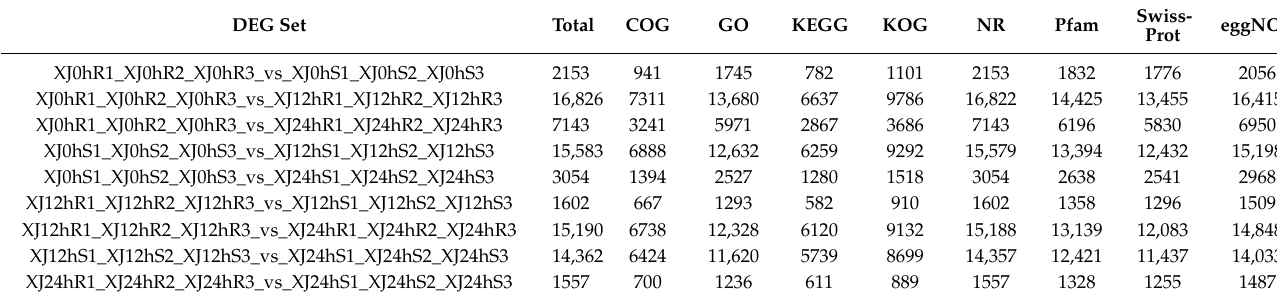
Table 6. Annotated statistical table of the number of differentially expressed genes.